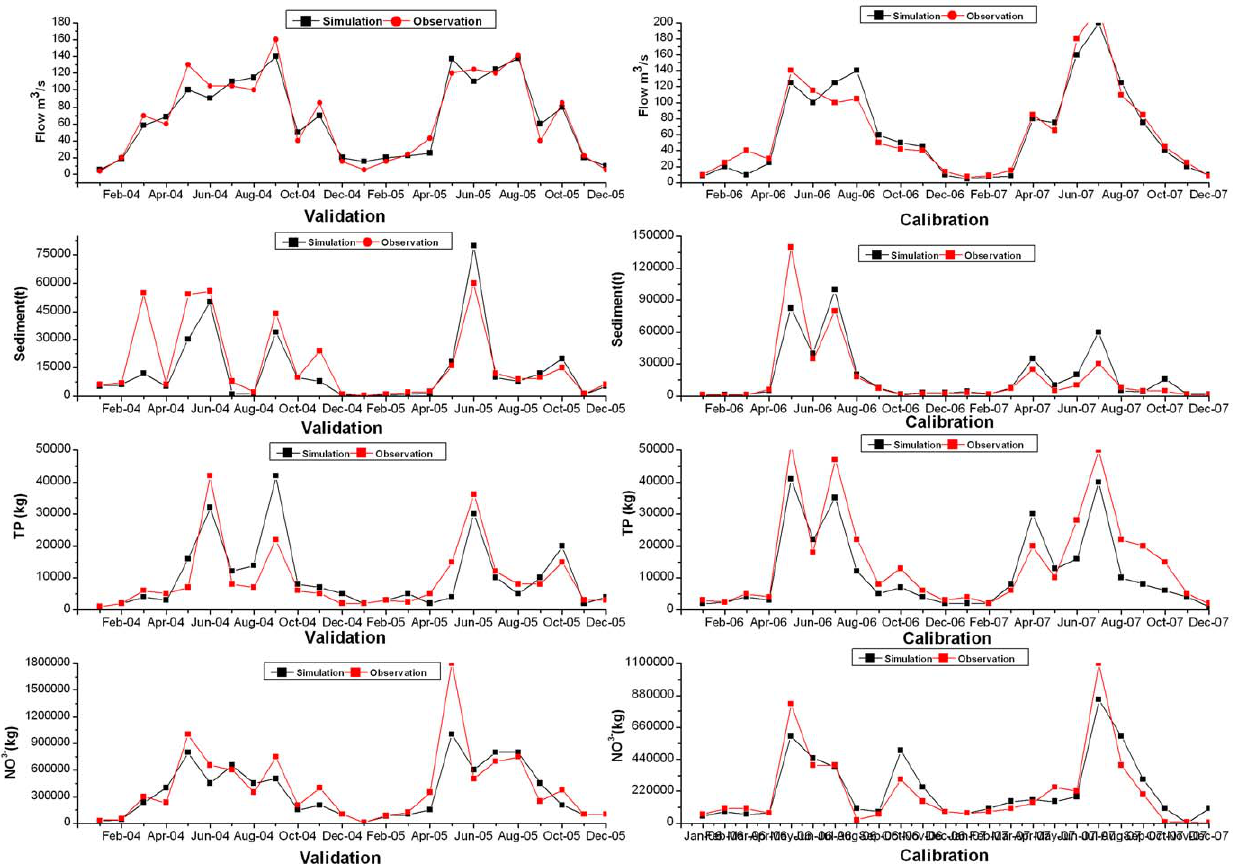
Figure 3. The goodness-of-fit results obtained during the calibration and verification period. doi:10.1371/journal.pone.0054520.g003 PLOS ONE |